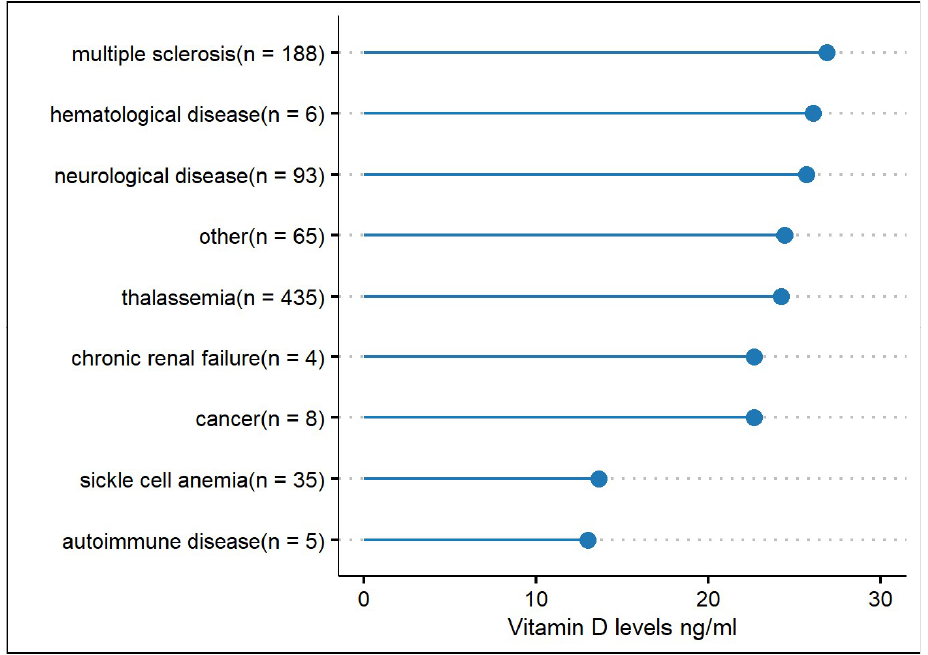
Figure 3. All types of recorded diseases for the subgroup of patients in the Greek database, and the mean Vitamin D levels associated with these. N = the number of subjects for each disease. Table 1. Descriptive characteristics and results for the Greek and Cypriot Database and multivariate analysis model.